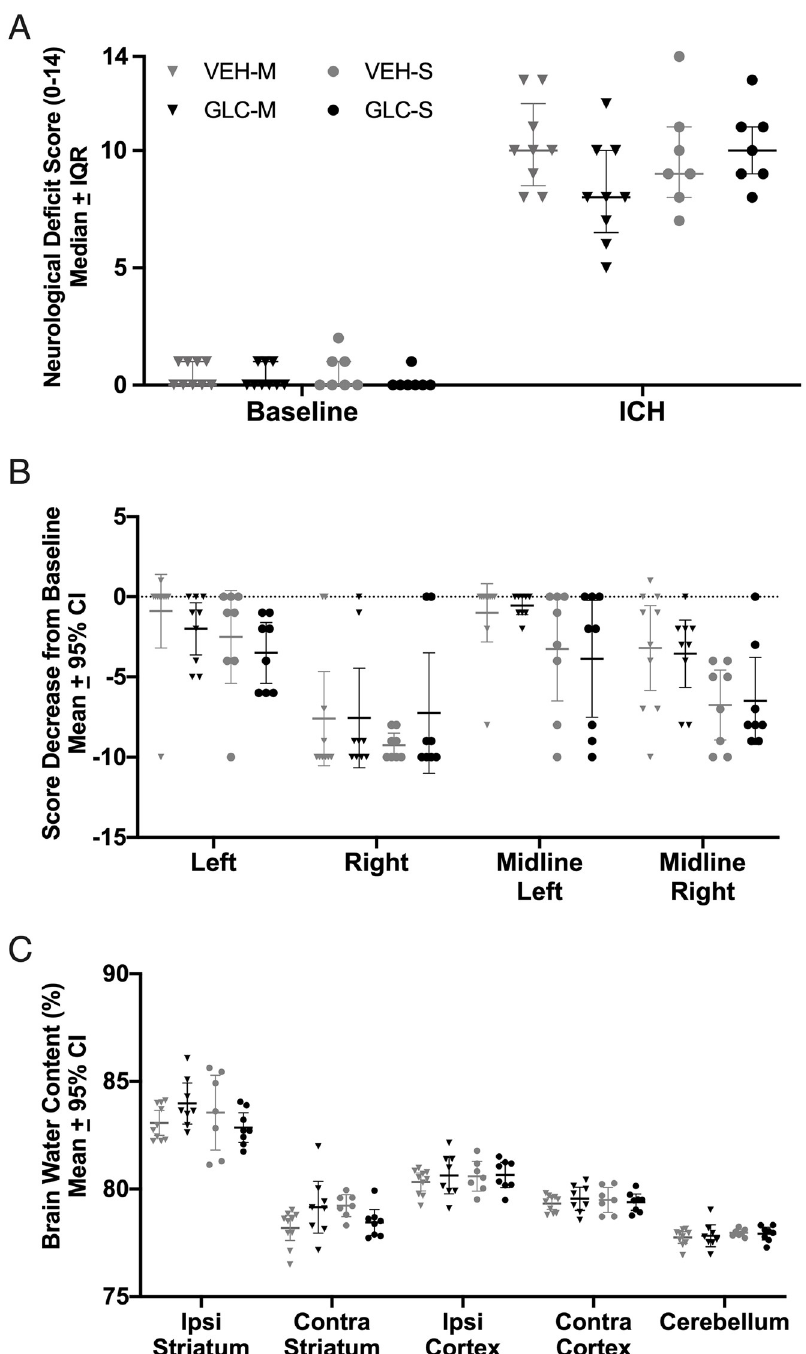
Fig 4. Experiment 2 behaviour and edema. All groups had increased brain water content in the ipsilateral striatum compared to the contralateral striatum (p < 0.0001). No meaningful benefit of glibenclamide was found for NDS (A, p = 0.1133) or forelimb placing of any paw (B, p � 0.1131) in either moderate (-M) or severe (-S) bleeds. Although VEH-M rats had somewhat better NDS scores, the differences were not significant (C, p = 0.0558). Glibenclamide also did not have an effect on brain water content in either severity (p = 0.8040). For forelimb placing, a dashed line was set at 0, which indicates no change from baseline.